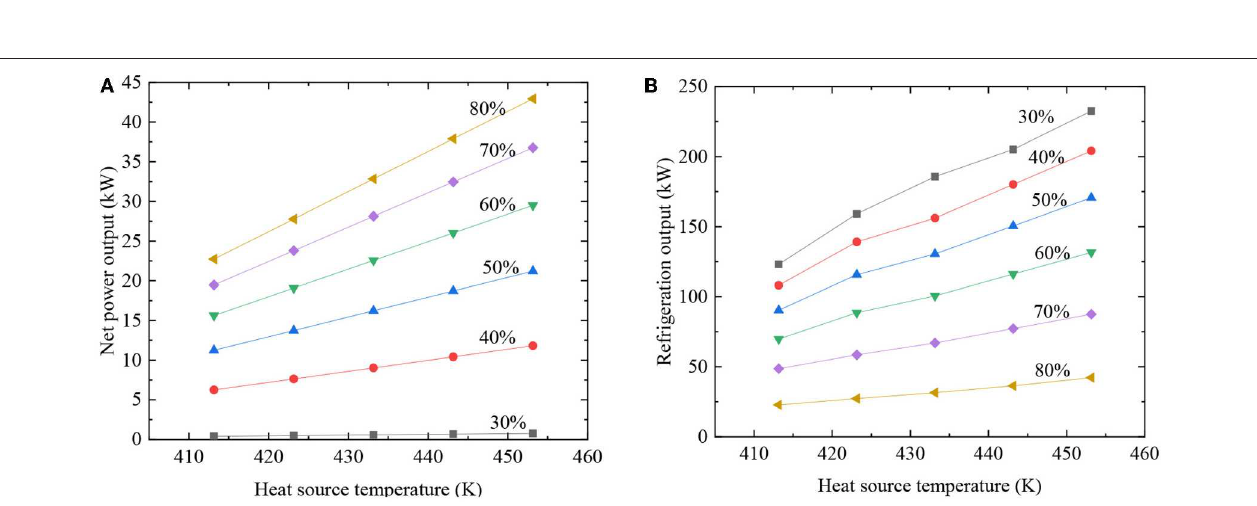
FIGURE 5 | Effect of heat source temperature and mass fraction. (A) Net power; (B) refrigeration output.